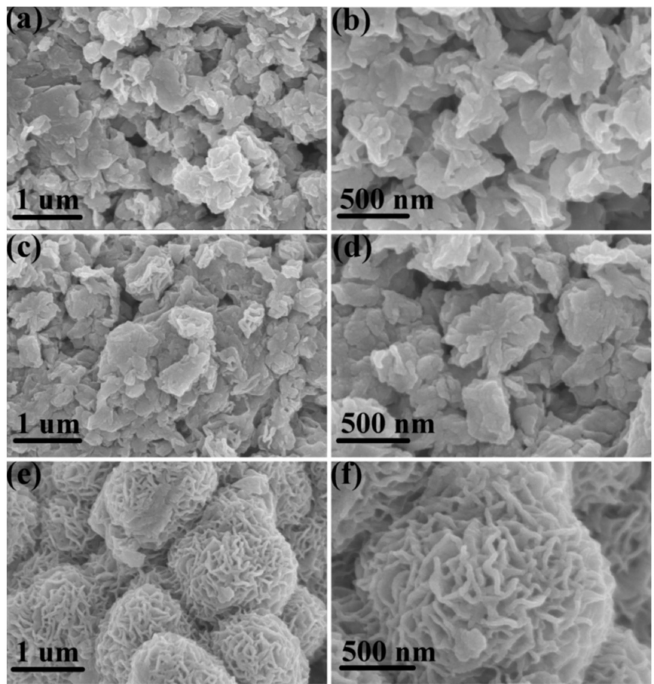
Figure 2. SEM images of ( a , b ) MoS 2 /RGO-1, ( c , d ) MoS 2 /RGO-2, and ( e , f ) MoS 2 /RGO-3 composites. X-ray diffraction (XRD) analysis was performed on MoS 2 /RGO-1, MoS 2